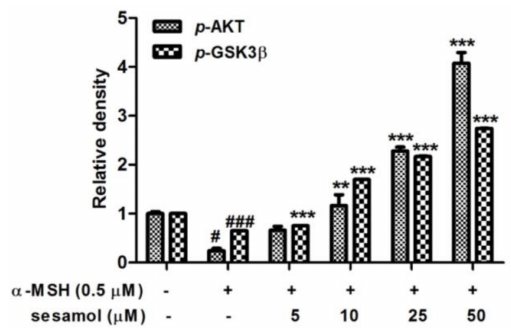
Figure 5. Effect of sesamol on α -MSH-induced protein expression of p -GSK3 β and p -AKT in B16F10 cells. Each value is presented, in comparison with the control group, as the mean ± SD., # p < 0.05, and ### p < 0.001; and, in comparison with the α -MSH treated group, as ** p < 0.01, and *** p < 0.001.